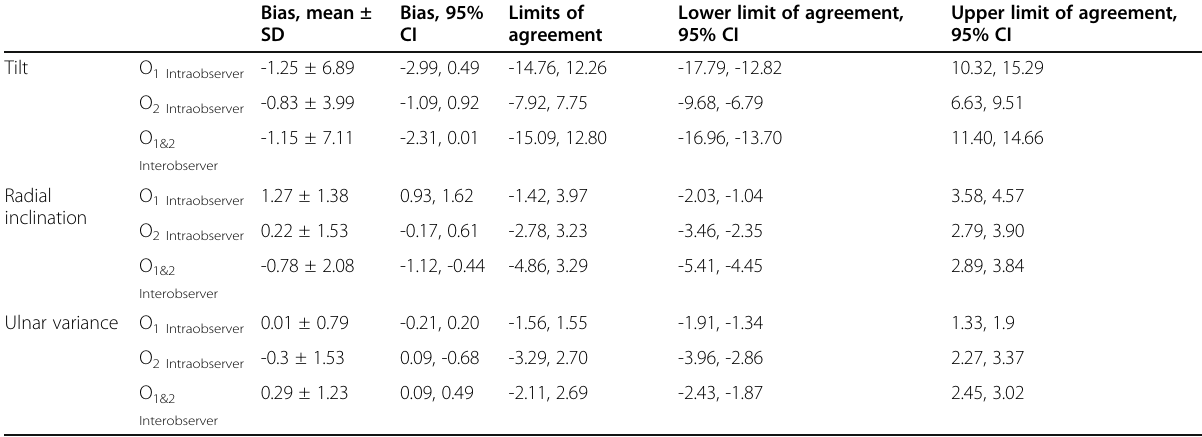
Table 3 Bland-Altman limits of agreement and bias (mean and SD). Interobserver agreement ( n = 147), intraobserver agreement ( n =